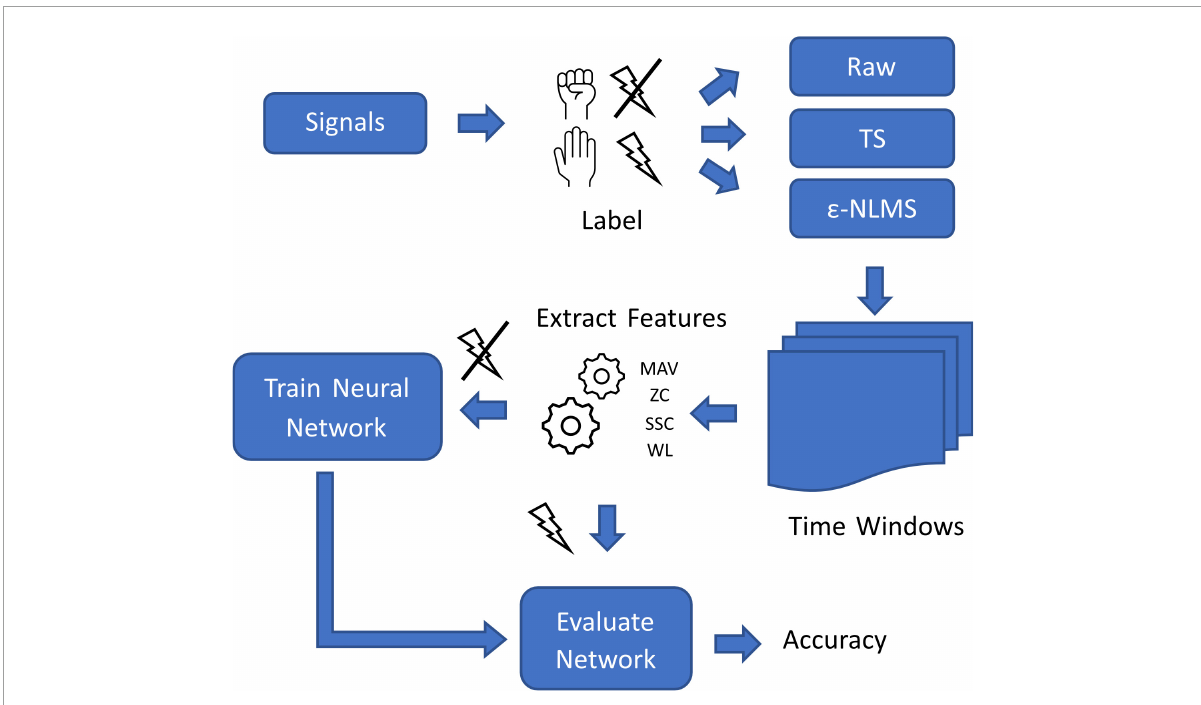
FIGURE3 Overview of the process used for evaluating offline myoelectric pattern recognition performance of the two algorithms on signals containing stimulation artifacts.